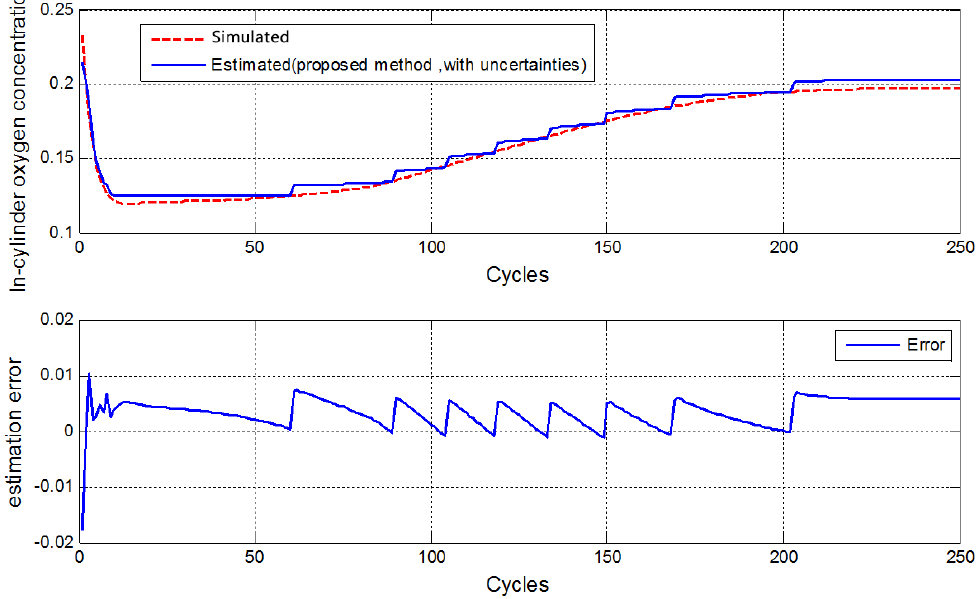
Figure 12. Performance of the data fusion method (with uncertainties, 10% model